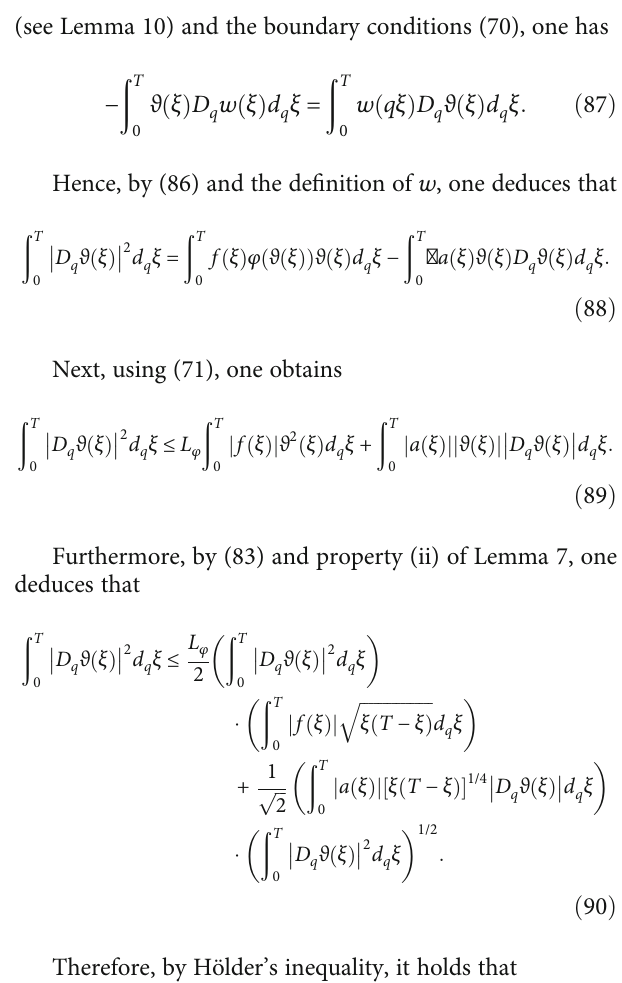
ffiffiffiffiffiffiffiffiffiffiffiffiffiffiffiffiffiffiffiffiffiffiffiffiffiffiffi q σ T T − q σ T ð